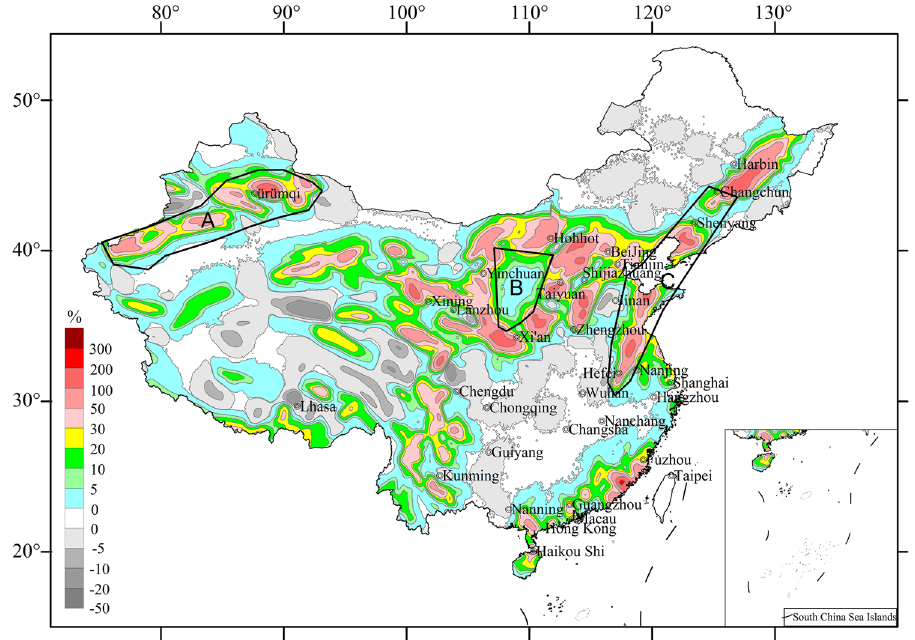
Fig. 7 Comparison of seismic hazards calculated using the new seismicity model with that using the FGSSM ((Results in this study − Result using FGSSM)/Result using FGSSM). The areas with increased seismic hazard are mainly dis- tributed in the Tianshan seismic belt (area A), seismic fault zones around the Ordos block (area B), and the Tanlu seismic belt (area